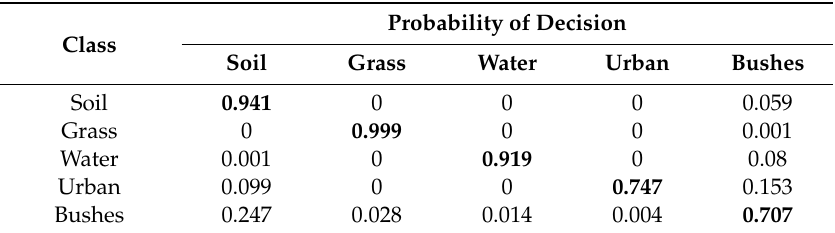
Table 21. Classification probabilities (confusion matrix) for the NN-based method trained for the original image and applied to the compressed image (PSNR-HVS-M = 30 dB).